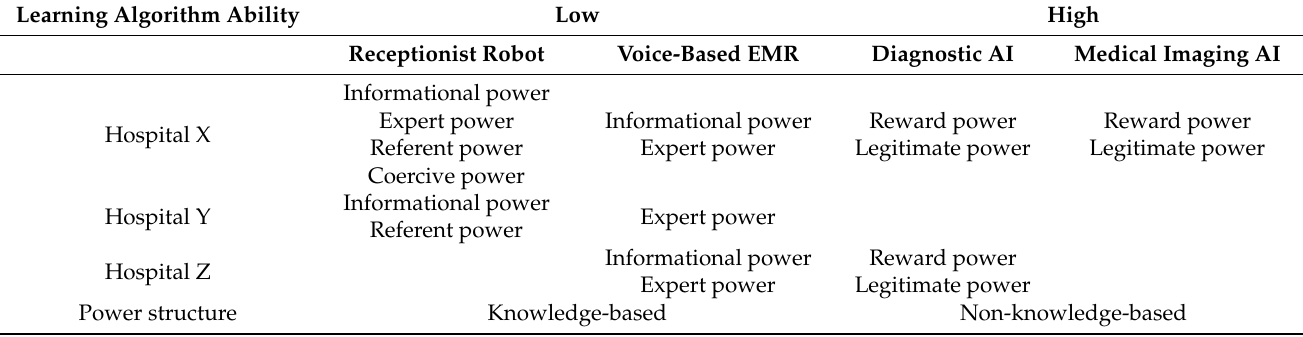
Table 6. Mapping the relationship between learning algorithm ability of AI and power structure. Learning Algorithm Ability